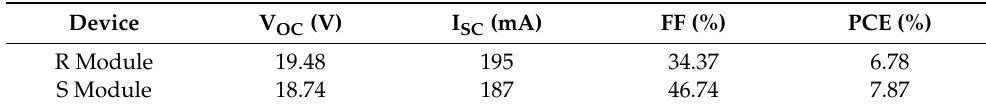
Figure 3. IV curves for the fabricated R ( blue ) and S ( black ) modules. The S module is adapted from reference [47]. The inset shows a photograph of these modules. Table 1. Photovoltaic parameters for the fabricated R and S modules obtained from the IV curves in Figure